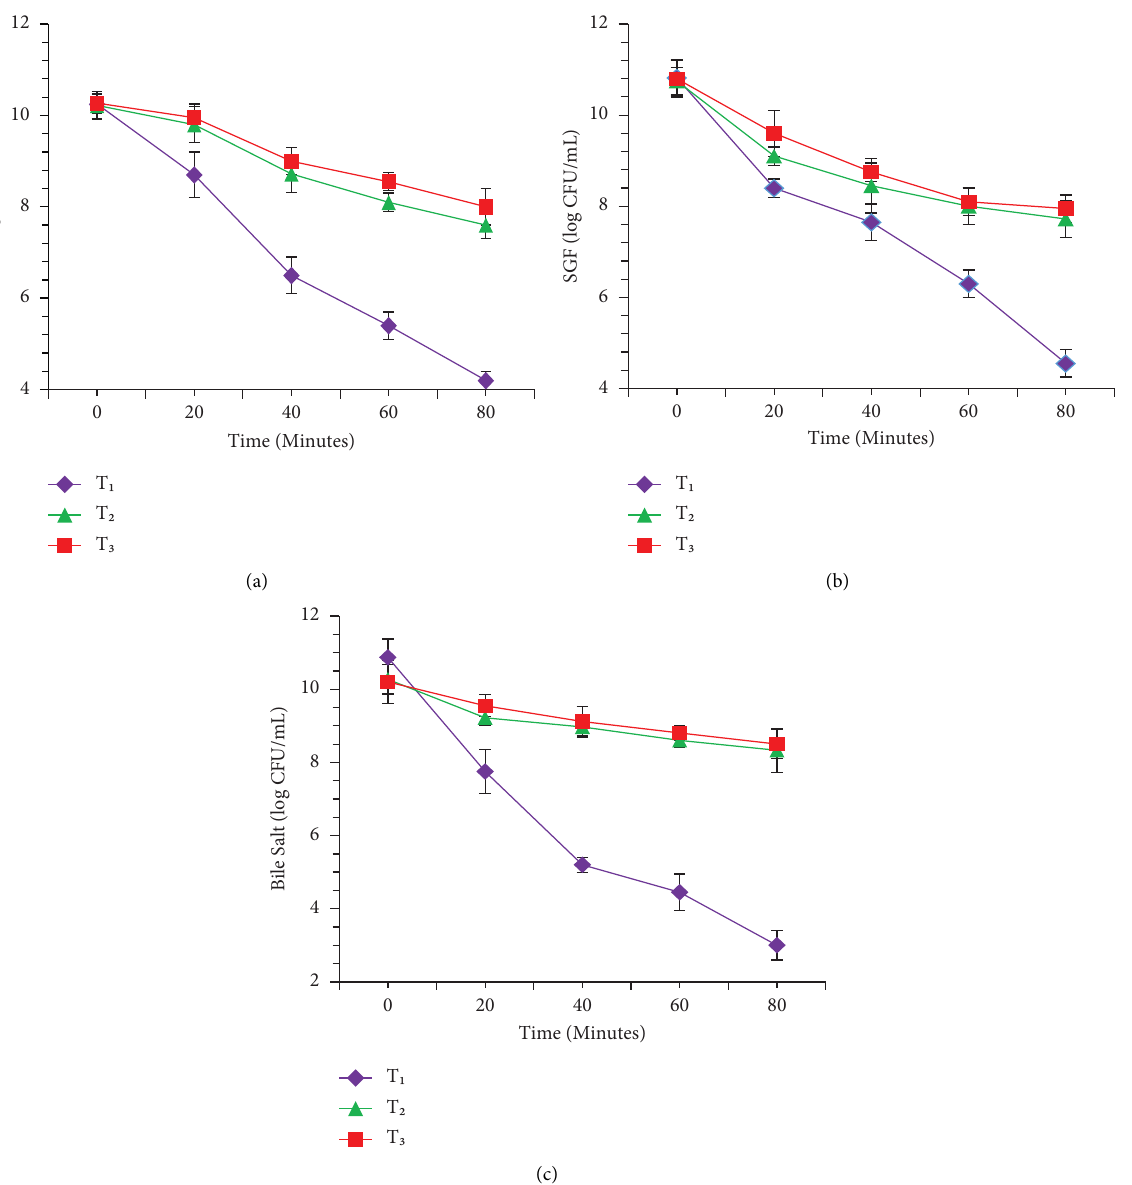
Figure 1: Survivability of free and encapsulated L. rhamnosus in (a) simulated intestinal fuid (SIF), (b) simulated gastric fuid (SGF), and (c) bile salt solution T 1 � free L. rhamnosus ; T 2 � sodium alginate (1.5%)-encapsulated L. rhamnosus ; T 3 � sodium alginate (1.5%)- and xanthan gum (0.5%)-encapsulated L. rhamnosus